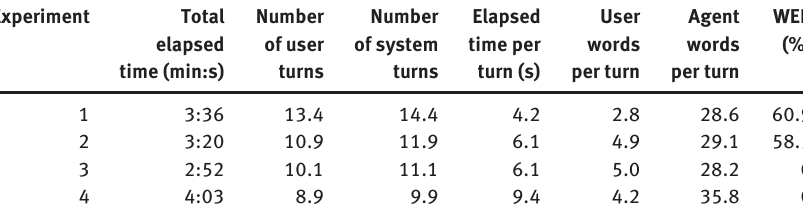
Table 7. Efficiency